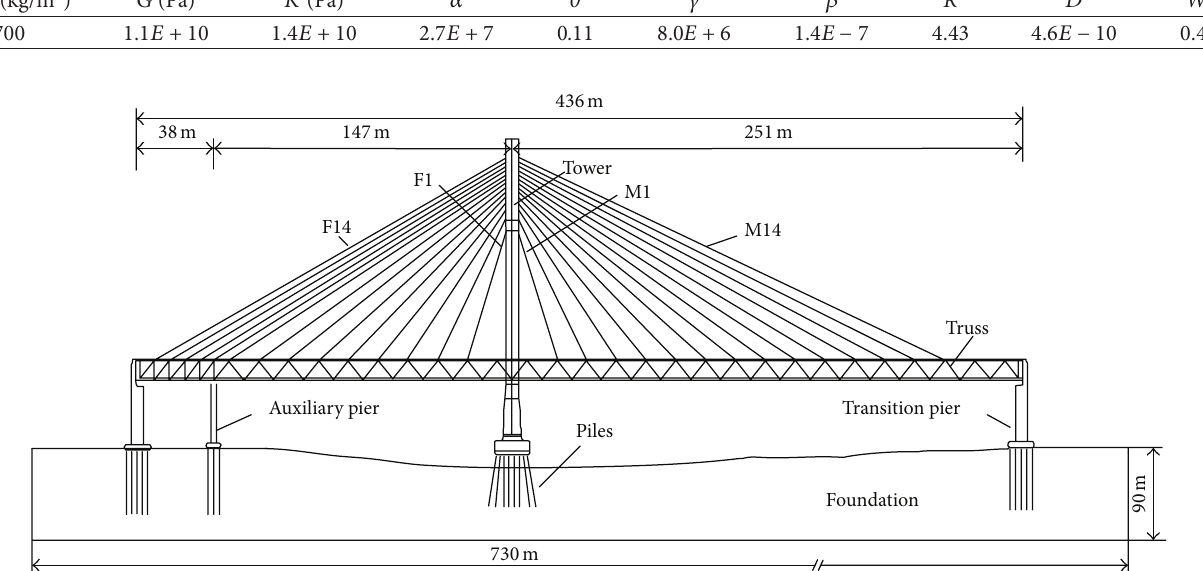
Figure 1: Configuration of the cable-stayed bridge with